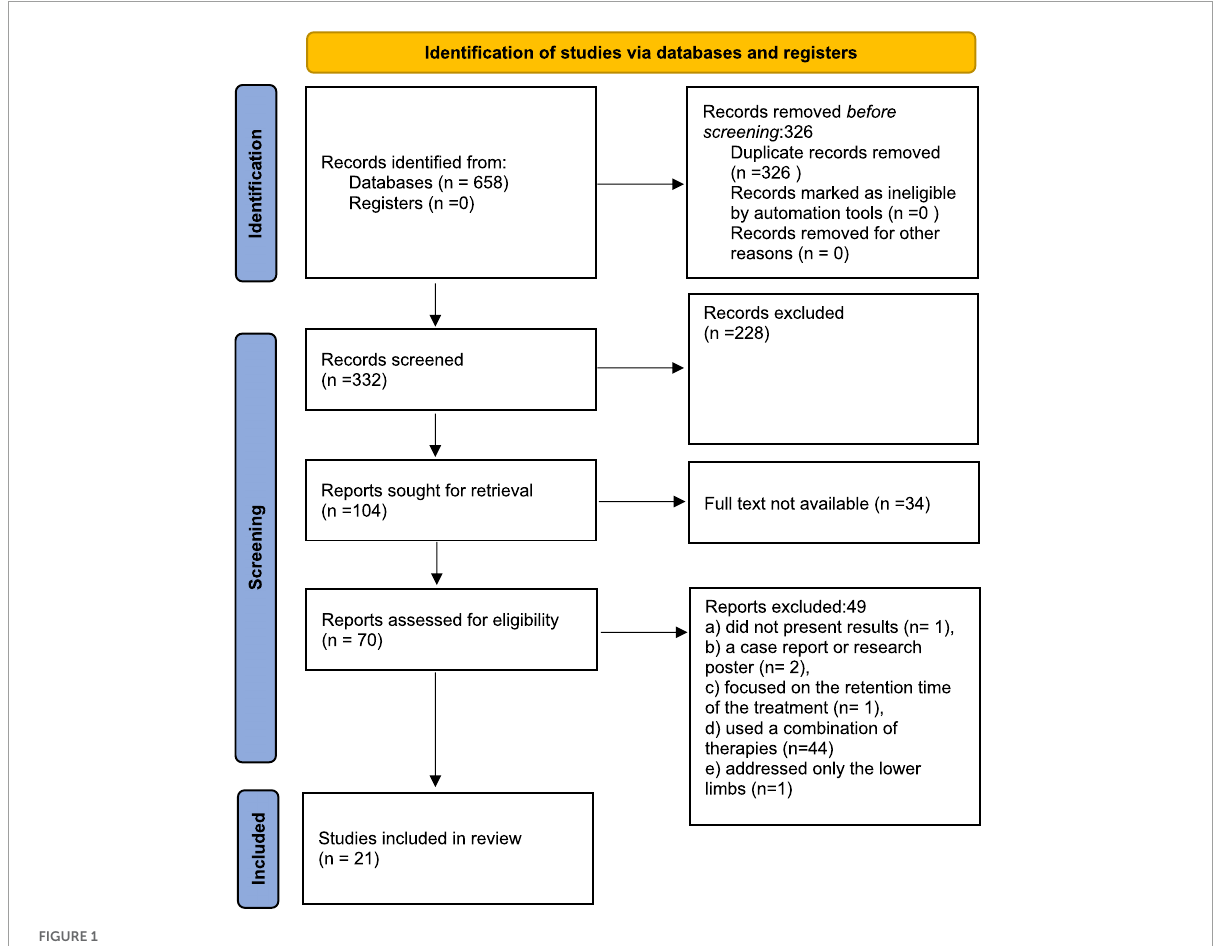
FIGURE1 PRISMA flow